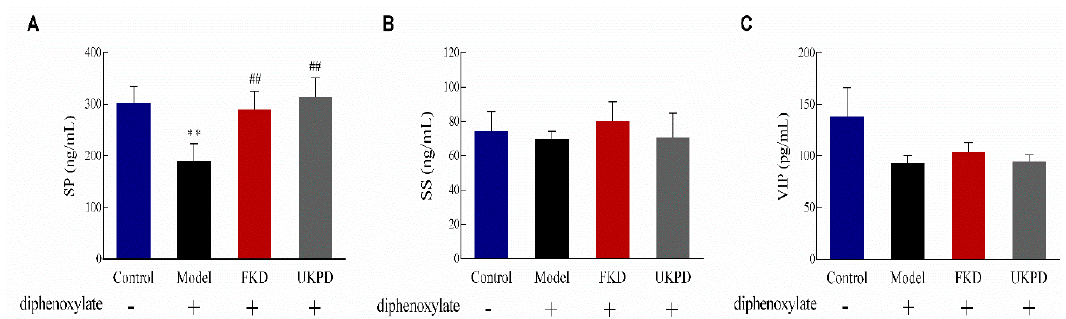
Figure 4. E ff ects of UKP and FK on ( A ) substance P (SP), ( B ) somatostatin (SS) and ( C ) vasoactive intestinal peptide (VIP) levels in portal vein plasma. Data are presented as the mean ± SD, n = 8–9 mice per group; two-way ANOVA; Bonferroni post hoc test. ** p < 0.001, compared with control group; ## p < 0.001, compared with model group.